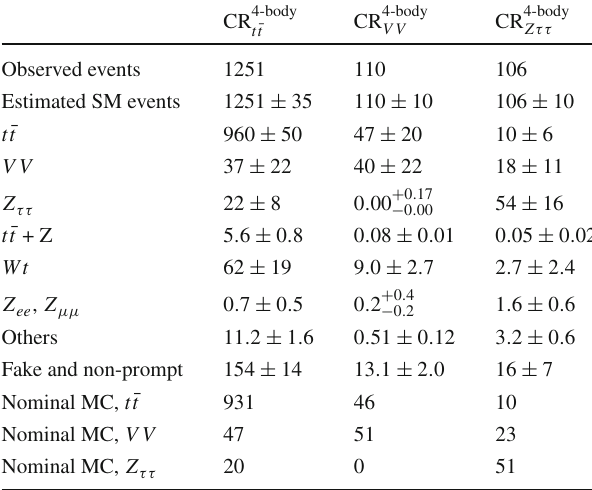
Table 12 Four-body selection background fit results for the CRs of the − body SR 4 background fit. The nominal predictions from MC simula- tion, are given for comparison for those backgrounds ( t ¯ t , V V and Z ττ ) that are normalised to data in dedicated CRs. Combined statistical and systematic uncertainties are